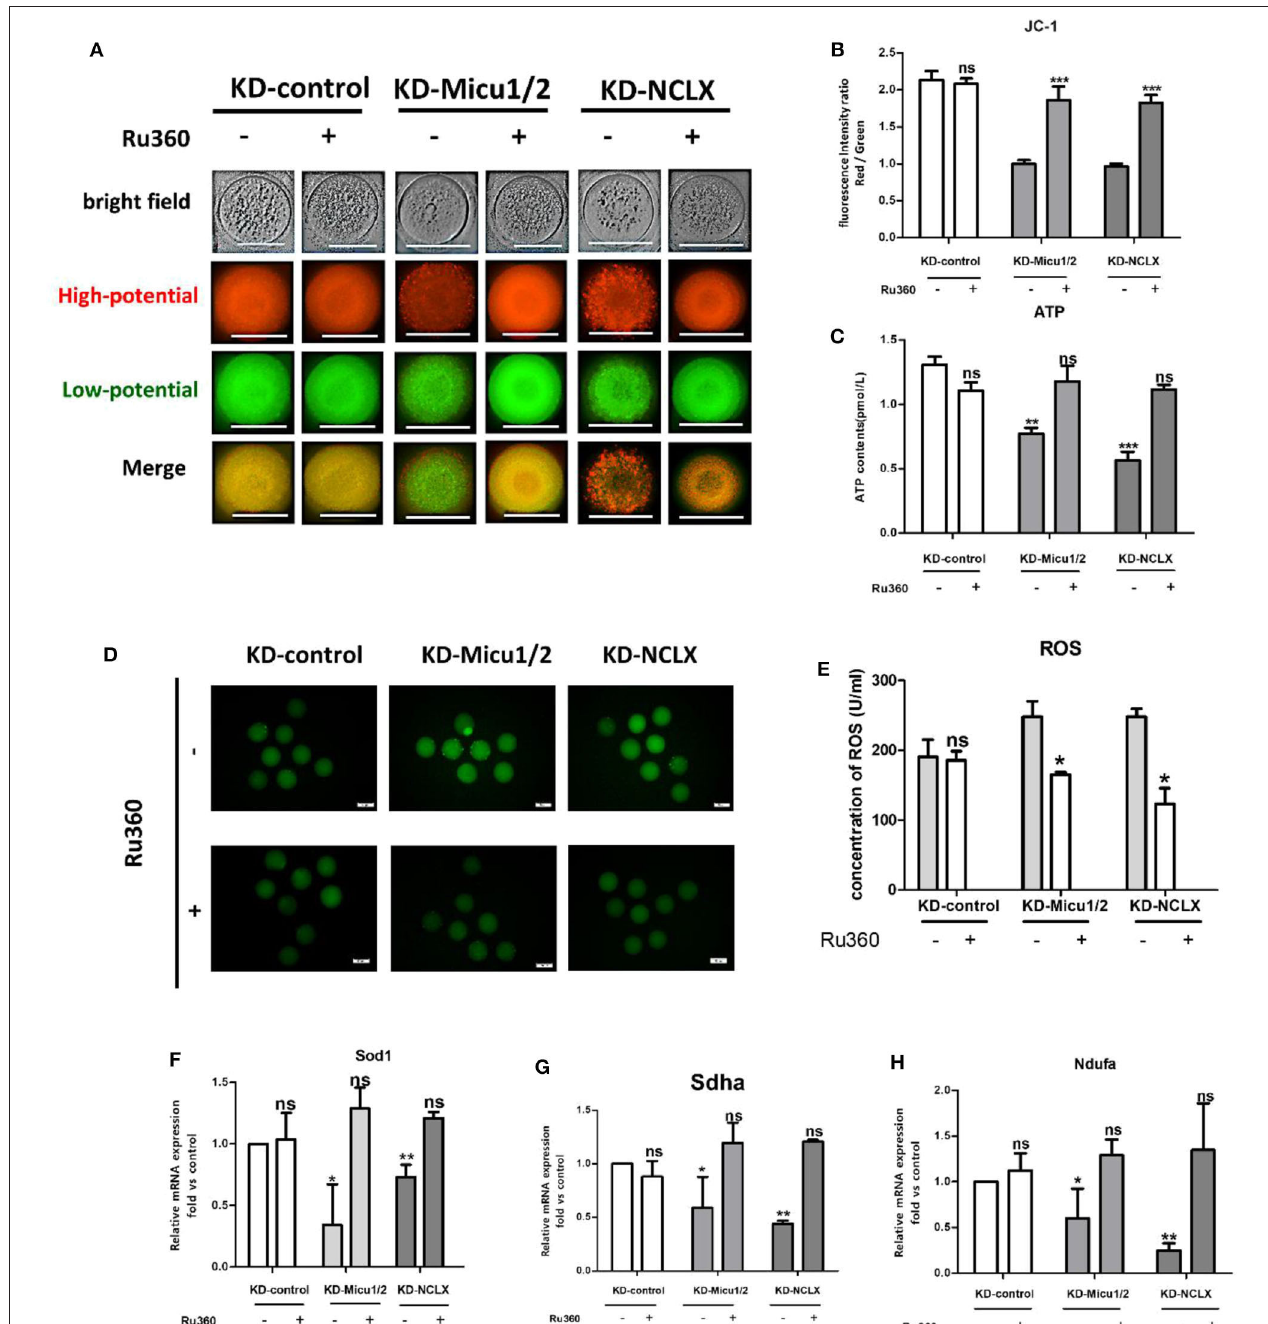
FIGURE 6 | Mitochondrial dysfunction and recovery of oocyte maturation by decreasing mitochondrial Ca 2 + levels. (A) Image of oocytes from KD-control, KD-control + Ru360, KD-Micu1/2, KD-Micu1/2 + Ru360, KD-NCLX and KD-NCLX + Ru360 were stained with JC-1. (B) Oocytes from KD-control, KD-control + Ru360, KD-Micu1/2, KD-Micu1/2 + Ru360, KD-NCLX, and KD-NCLX + Ru360 were stained with JC-1 and quantification of the Red/Green ratio of mitochondrial membrane potential ( 1 φ m) in oocytes ( n = 30 for each group). (C) ATP (pM) concentrations were evaluated in individual oocytes from KD-control, KD-control + Ru360, KD-Micu1/2, KD-Micu1/2 + Ru360, KD-NCLX, and KD-NCLX + Ru360 ( n = 30 for each group). (D) Representative images of CM-H2DCFDA fluorescence (green) in germinal vesicle (GV) stage oocytes from KD-control, KD-control + Ru360, KD-Micu1/2, KD-Micu1/2 + Ru360, KD-NCLX, and KD-NCLX + Ru360. Scale bar: 50 µ m. (E) Quantification of the relative levels of ROS in oocytes. ( n = 35 for each group). (F–H) Expression levels of genes involved in mitochondrial function ( Ndufs3 , Sdha , and Sod1 ) in GV-stage oocytes from KD-control, KD-control + Ru360, KD-Micu1/2, KD-Micu1/2 + Ru360, KD-NCLX, and KD-NCLX + Ru360 ( n = 30 for each group). Student’s t- test and one-way ANOVA were utilized for statistical analyses. * P < 0.05, ** P < 0.01, *** P < 0. 001; ns, non-significant ( P > 0.05). Error bars indicate SEM.